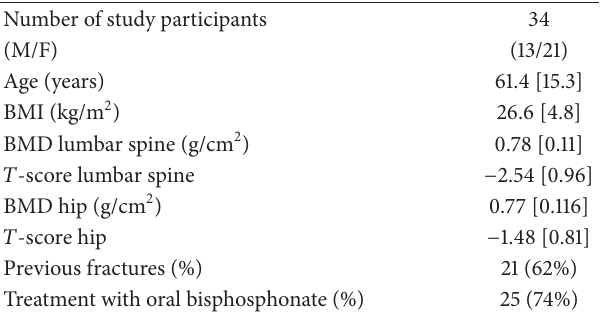
Table 1: Summary of subjects demographics. Data are shown as mean